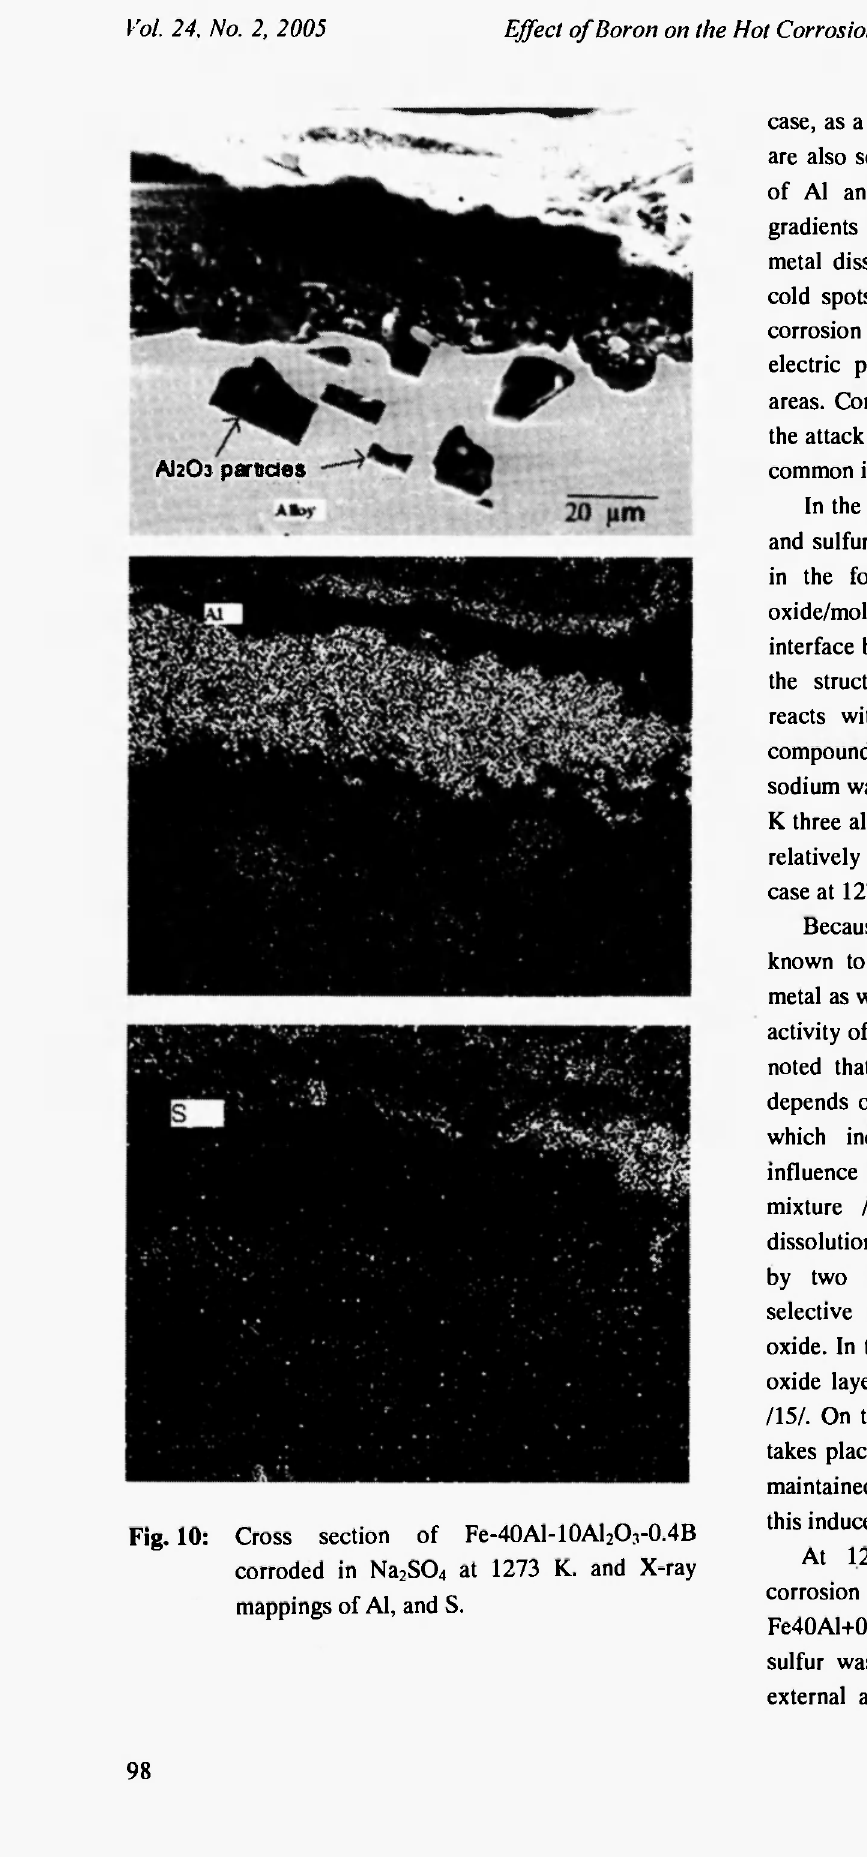
Fig. 10: Cross section of Fe-40Al-10Al 2 O r 0.4B corroded in Na 2 S0 4 at 1273 K. and X-ray mappings of Al, and